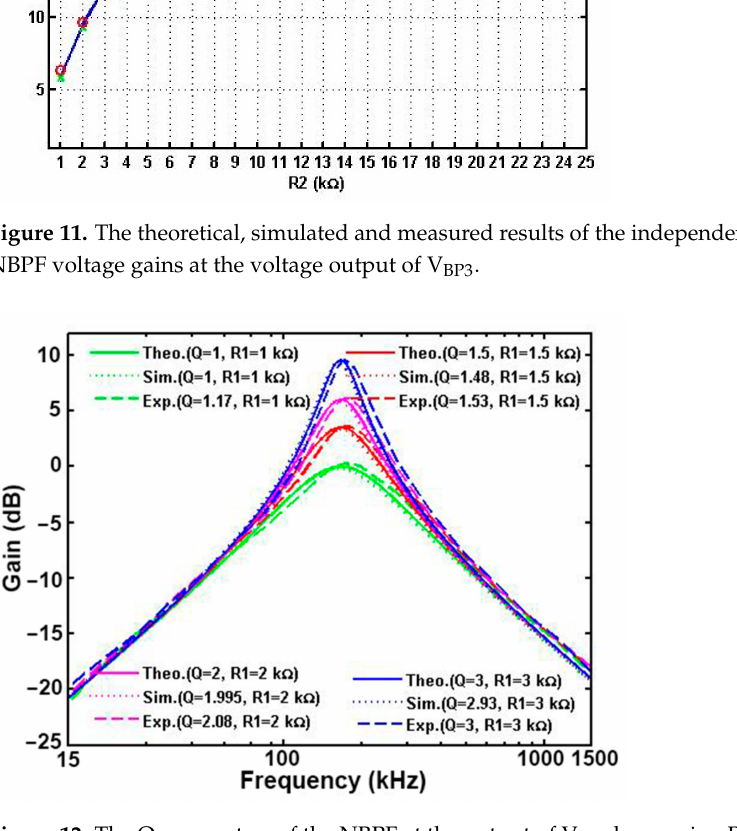
Figure 12. The Q parameters of the NBPF at the output of V BP2 by varying R 1 while maintaining f o .